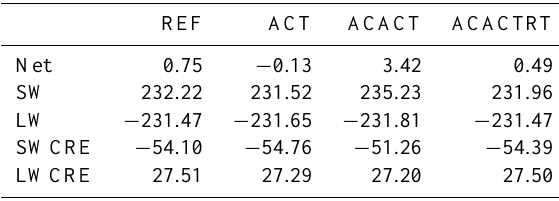
Table 3. Pre-industrial global mean values in each model configu- ration for (from top to bottom) the net radiation balance, net short- wave (SW) radiation, net longwave radiation (LW), SW cloud ra- diative effect (SWCRE) and LW cloud radiative effect (LWCRE) in Wm − 2